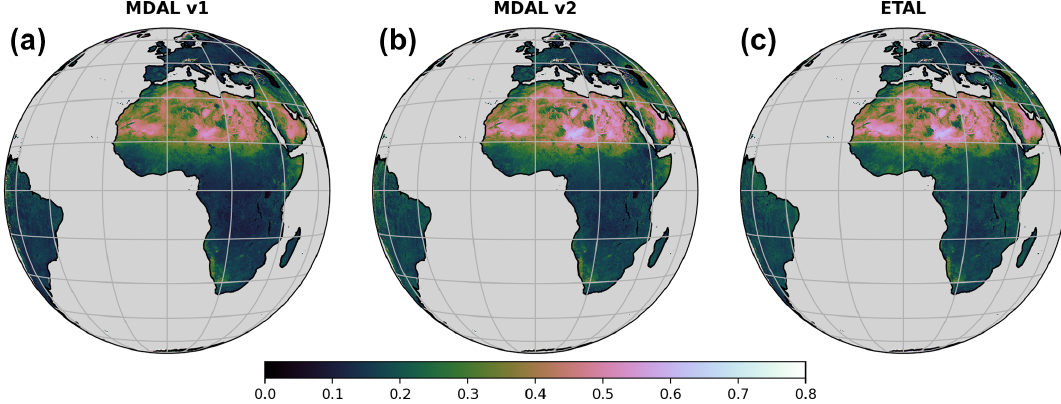
Figure 3. Broadband bi-hemispherical (BB-BH) albedo of MDAL v1, MDAL v2 and resampled ETAL. Date: 15 April 2021. Table 2. In situ stations used for comparison with MDAL as well as properties of nearest SEVIRI pixel and surrounding MODIS pixels. In situ footprint was calculated using Eq. (1); in situ vegetation is inferred from visual inspection of high-resolution satellite images (https: //earthexplorer.usgs.gov, last access: 22 March 2022). SEVIRI footprint vegetation types based on MODIS land cover MCD12Q1 (Sect. 3.5); it should be noted that the automatic classification algorithm may not always match “ground truth” (e.g., savanna classification at Cabauw). SEVIRI and MODIS footprint sizes based on distance between center coordinates of neighboring pixels.